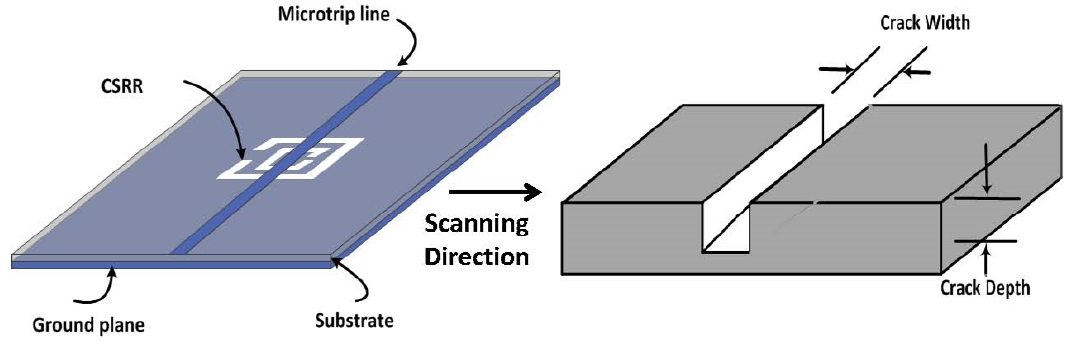
Figure 1. A schematic of a CSRR excited by a microstrip line used as a near-field sensor to detect defects in metallic